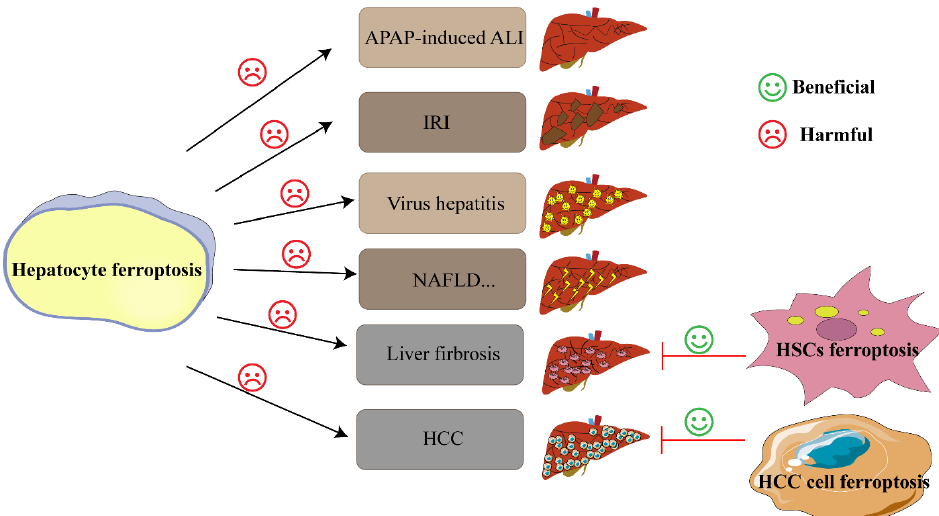
Figure 2. Various effects of ferroptosis on different liver diseases. In most cases, hepatocyte ferroptosis can aggravate the progression of liver damage. However, ferroptosis occurring in HSCs and liver cancer cells can improve the symptoms of liver fibrosis and hepatocellular carcinoma, respectively. Abbreviations: ALI: acute liver injury; HSC: hepatocyte stellate cell; IRI: ischemia reperfusion injury; NAFLD: non-alcoholic fatty liver disease.